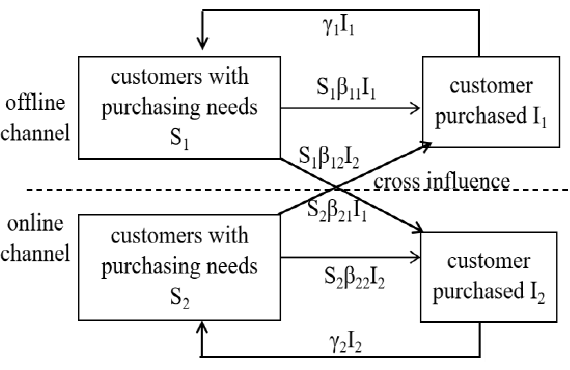
Figure 4. The dual-channel infectious disease SIS model for the pharmaceutical supply chain.